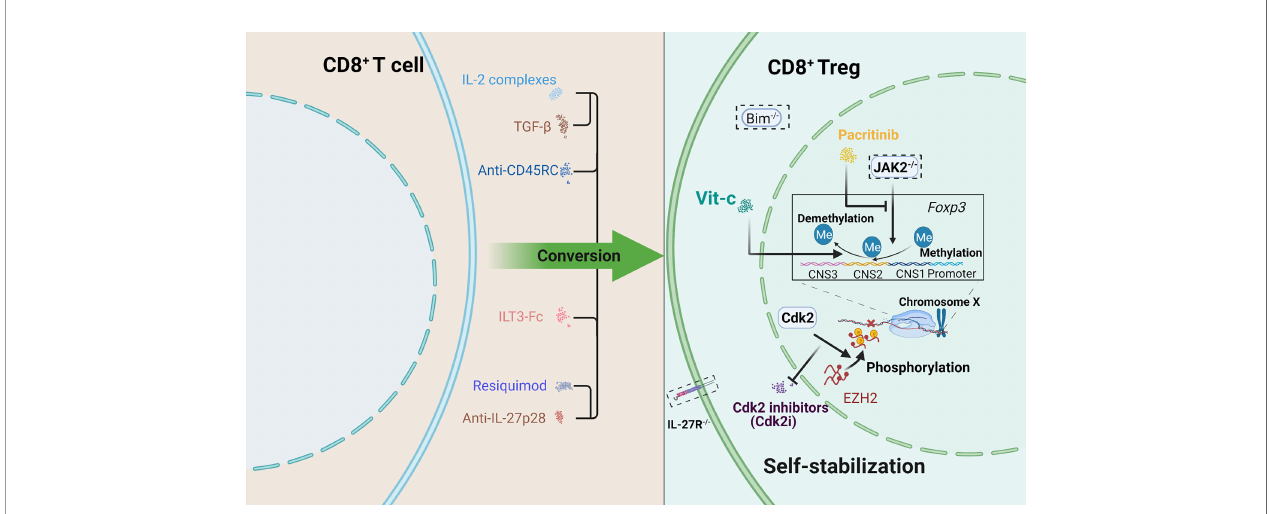
FIGURE 2 | Schematic depicting several attempts to optimize CD8 + Tregs. Two aspects were included: promoting conversion and maintaining self-stabilization. How to maintain stable expression of Foxp3 is a priority. Some approaches offer new therapeutic ideas for the clinic. A dotted box indicates gene